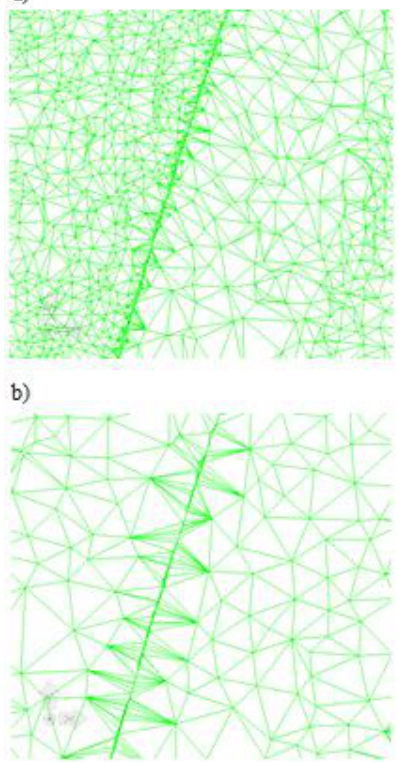
Figure 14. a) Delaunay triangulation of Step1 result b) Delaunay triangulation of Step1 result and PMin < 0.005 m and TriMin < 0.5 m.